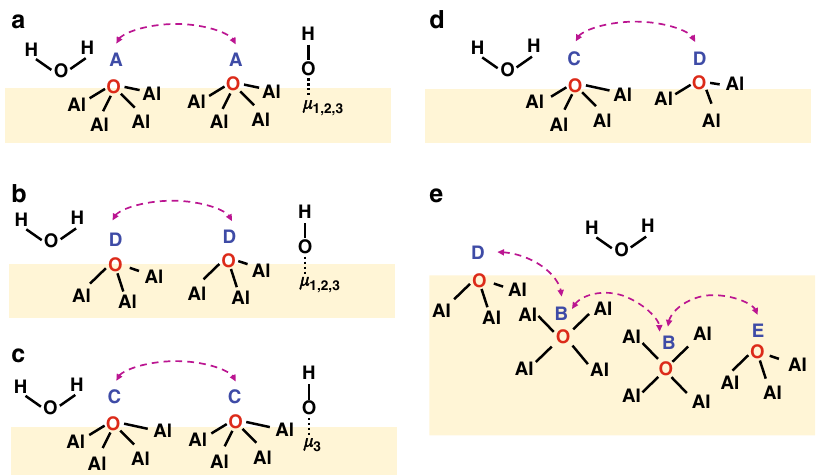
Fig. 5 Proposed local structure models of oxygen species in γ -Al 2 O 3 . a – e Letters A-E represent fi ve distinct bare oxygen sites. The purple dotted arrows indicate the spatial proximities between two speci fi c bare oxygen sites. Surface terminal ( μ 1 ), doubly ( μ 2 ) and triply ( μ 3 ) bridging hydroxyl groups